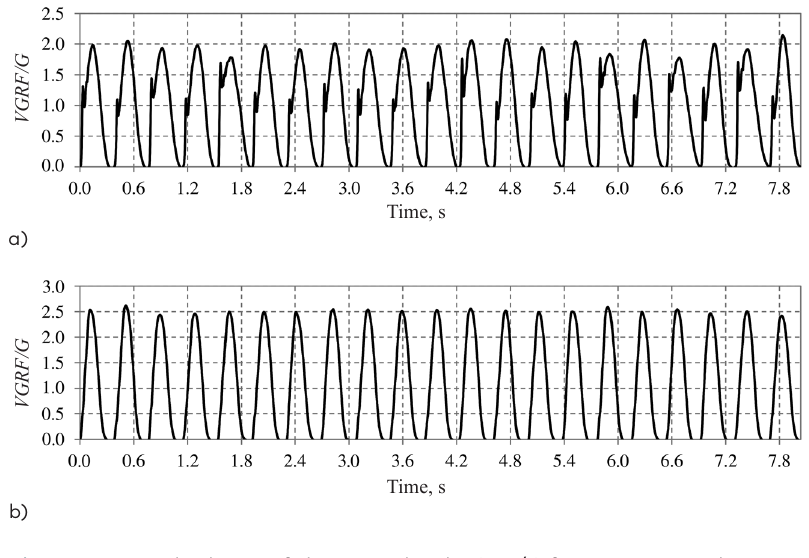
Figure 4. Example charts of the normalised VGRF / G forces generated by a) a heel strike runner ( f r = 2.60 Hz, G = 51.6 kg), b) a forefoot strike